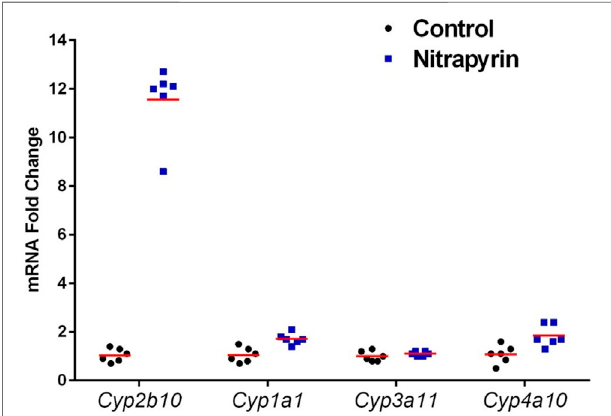
FIGURE 2 | Individual Biological Replicates of Gene Expression Data in Female B6C3F1 Mice Treated with 0 or 125 mg/kg/day Nitrapyrin for 4 days. Gene expression data showing biological replicates and group means of nitrapyrin-treatedfemalemiceat125 mg/kg/dayandunexposedcontrol mice. Each data point corresponds to the mRNA fold change for an individual animal compared to the control group mean value which was set to 1. Six animals/treatment group were examined for gene expression data.